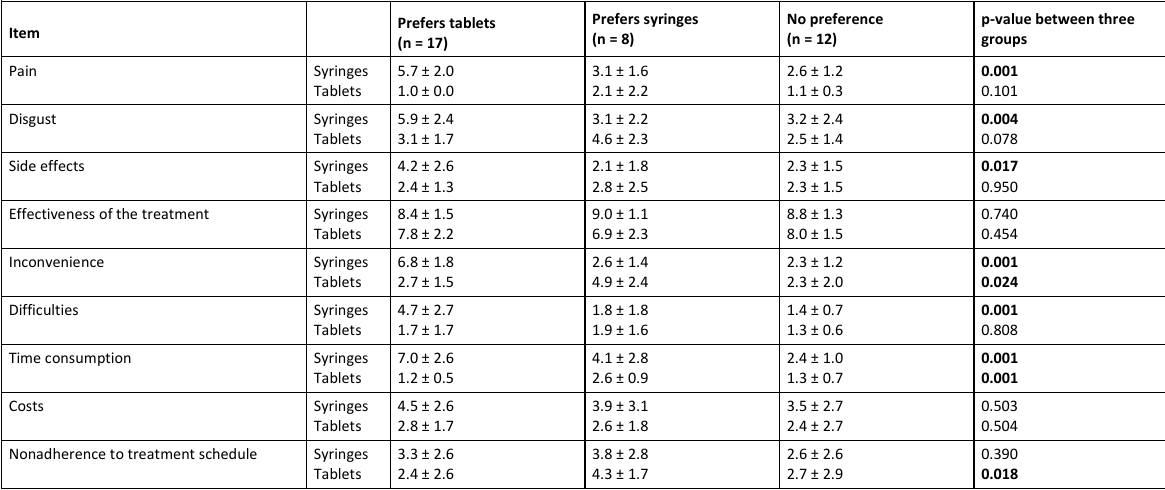
Table 3: Patients’ answers to nine items known to influence treatment preference, before randomisation. Answers are sorted according to the first question “Which treat- ment do you prefer?” tablets / syringes / no preference. Each item was to be answered twice for therapy with syringes and with tablets. The higher the score the higher the anticipated effect of the corresponding item on a Likert scale 1–10. Data are given as mean ±SD. A p-value <0.05 indicates a significant difference between the group with the highest values versus the group with the lowest values.